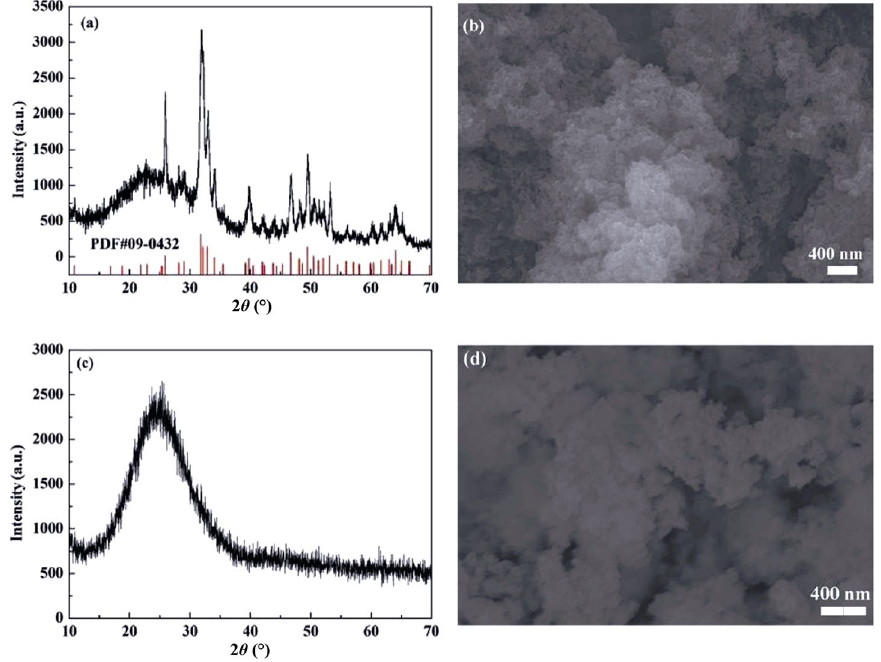
Fig. 1 Structure and morphology of hydroxyapatite and sodium aluminum silicate: (a, b) hydroxyapatite powder and (c, d) sodium aluminum silicate